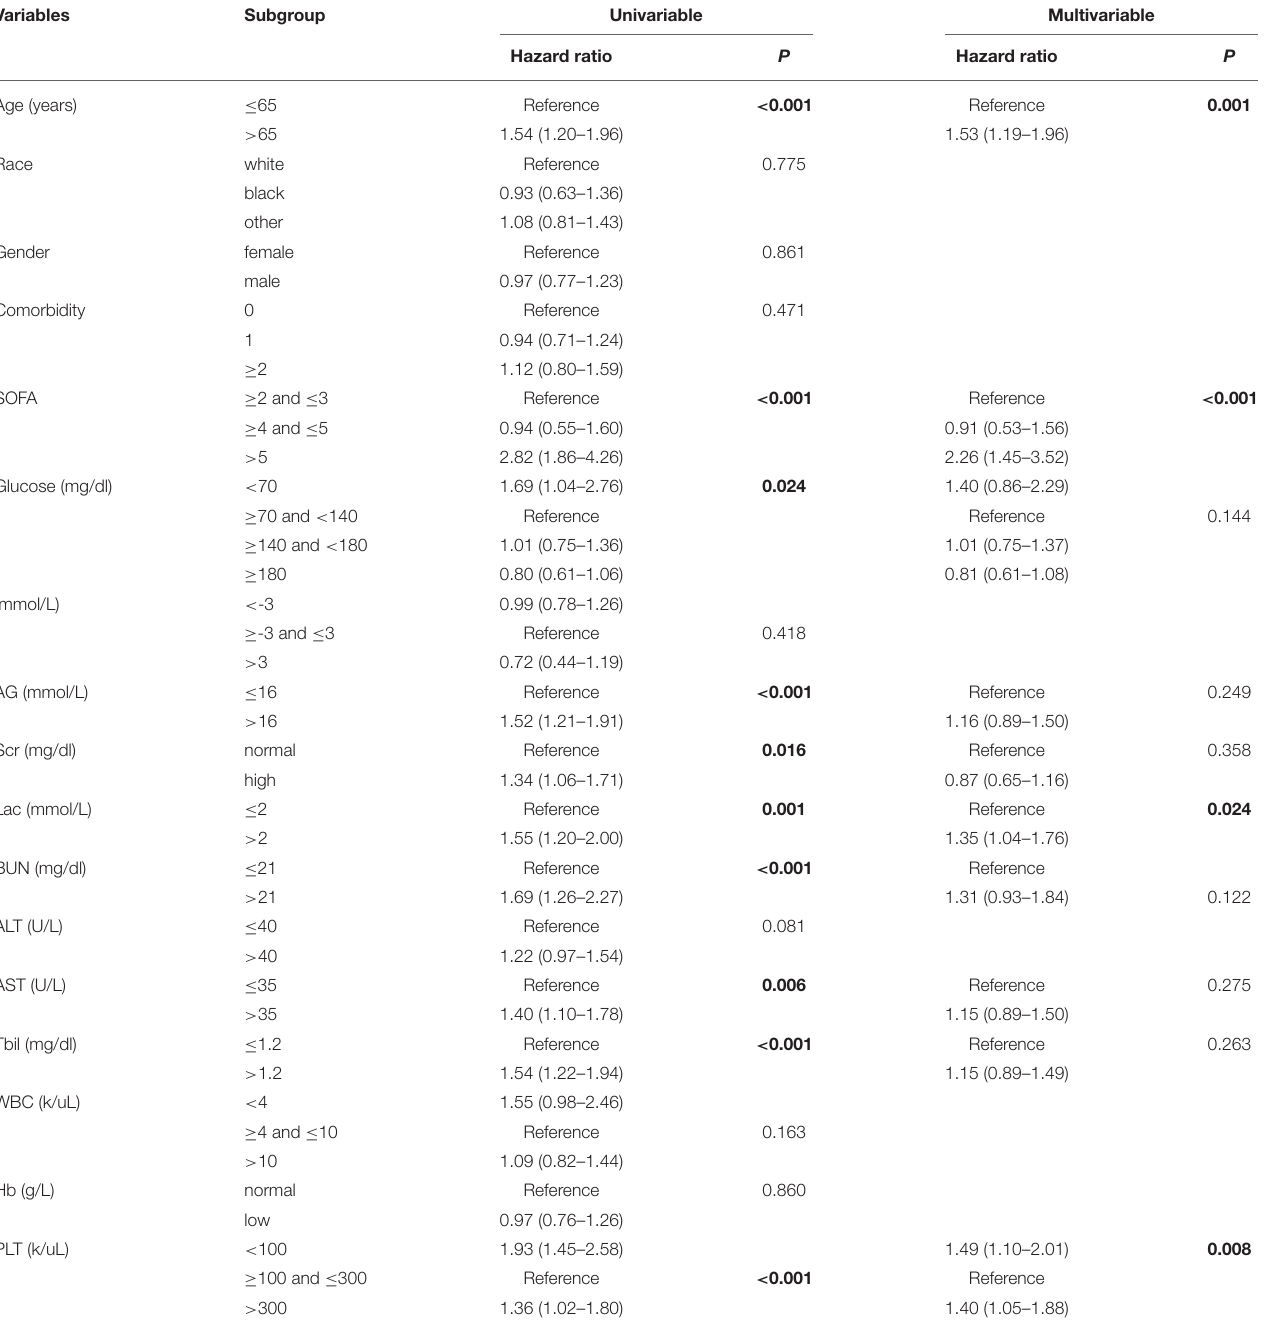
TABLE 3 | Univariate and multivariate Cox regression analyses of predictive variables correlated with 30-day mortality in septic patients with diabetes mellitus.